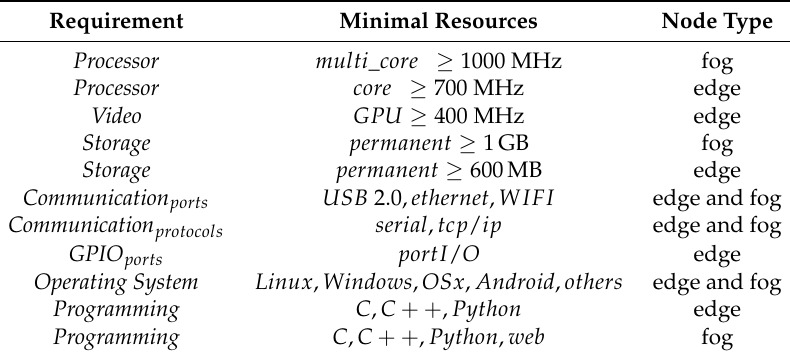
Table 6. Minimal hardware requirements of edge and fog